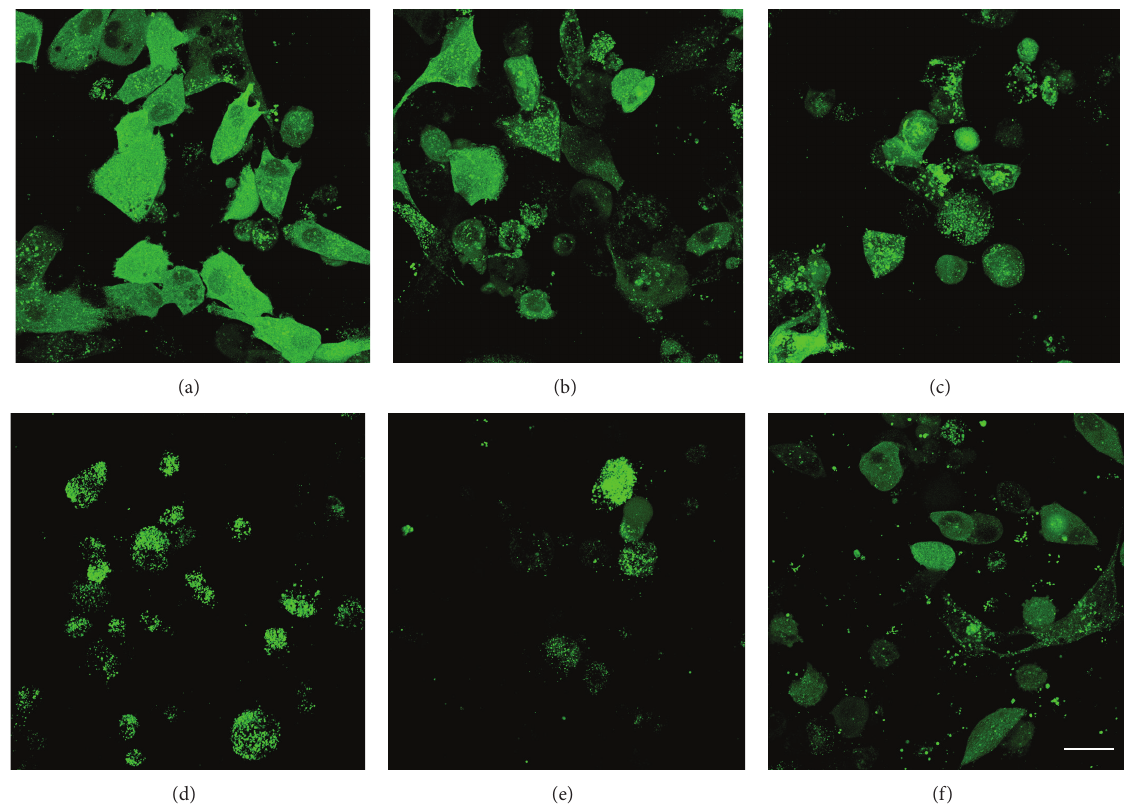
Figure 9: Autophagy in PC3 prostate cancer cell line stably expressing EGFP-LC3 (green fluorescence). Series of optical sectiones (Z-stack) were combined together. (a) control; (b) genistein (100 𝜇 M); (c) Gen-5 󸀠 (20 𝜇 M); (d) Ram-2 󸀠 (3 𝜇 M), (e) Ram-3 󸀠 (40 𝜇 M), (f) Ram-5 󸀠 (20 𝜇 M).